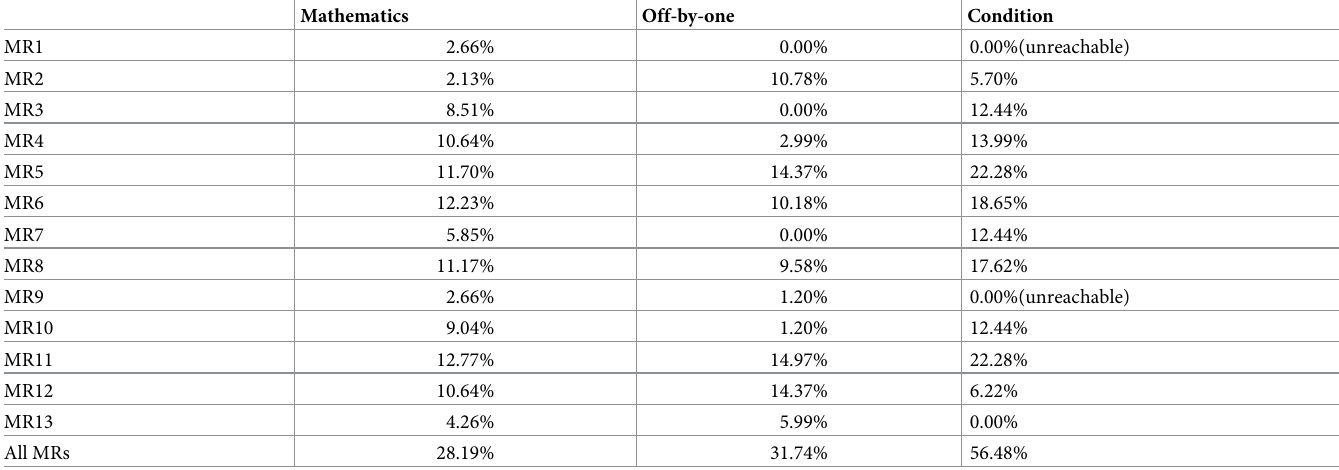
Table 4. Mutation scores of MRs for different types of